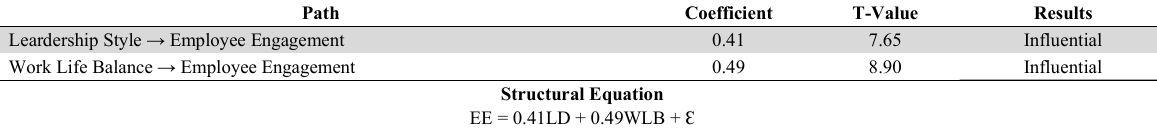
The Influence of Leadership Style and Work Life Balance on Employee